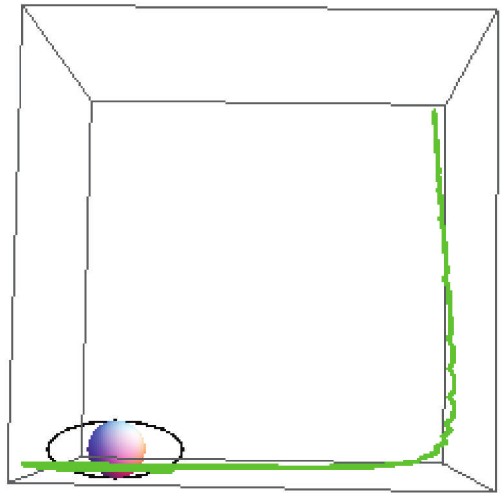
𝓁 = 1.5 Figure 15: Effect of magnetic field 𝑏 on escape velocity ( V esc